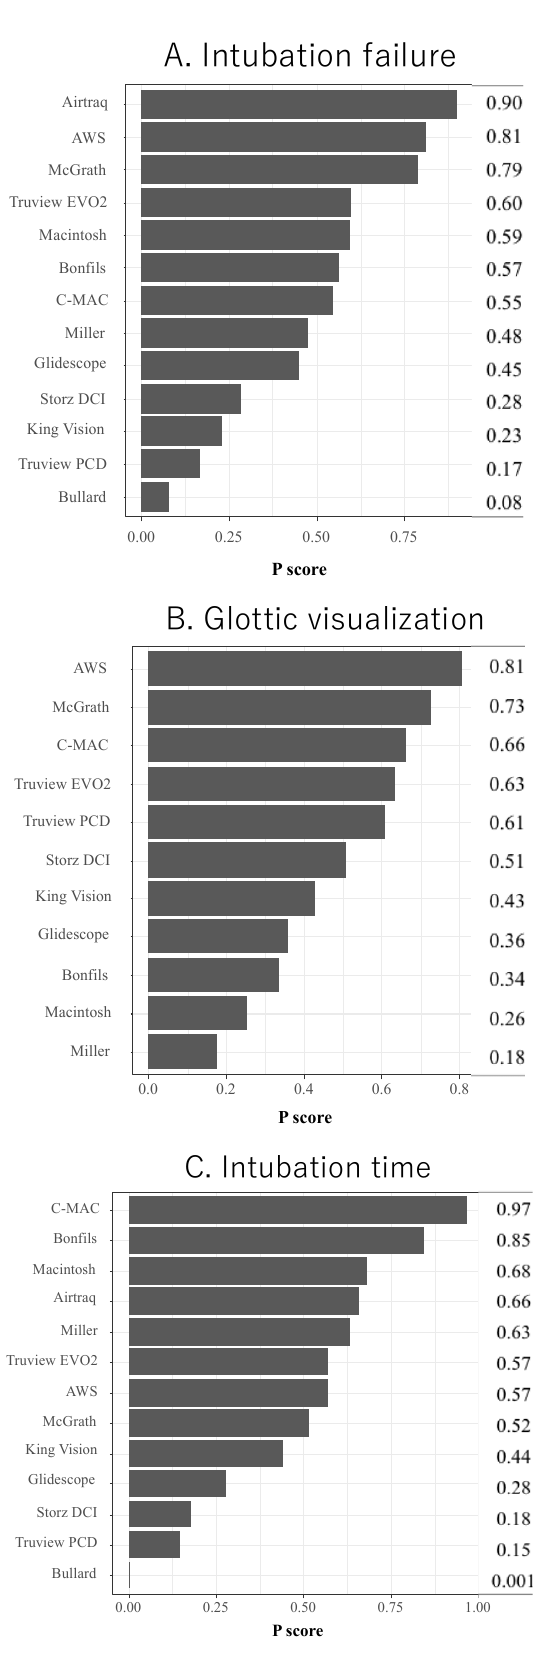
Figure 2. Forest plot of the main results. ( A ) Forest plot of the intubation failure of tracheal intuba- tion using the indirect laryngoscope compared with the Macintosh laryngoscope. ( B ) Forest plot of glottic visualization with the indirect laryngoscope compared with the Macintosh laryngoscope, Cormack–Lehane grade 1 and 2 vs. other grades. ( C ) Forest plot of intubation time for tracheal in- tubation using the indirect laryngoscope compared with the Macintosh laryngoscope.